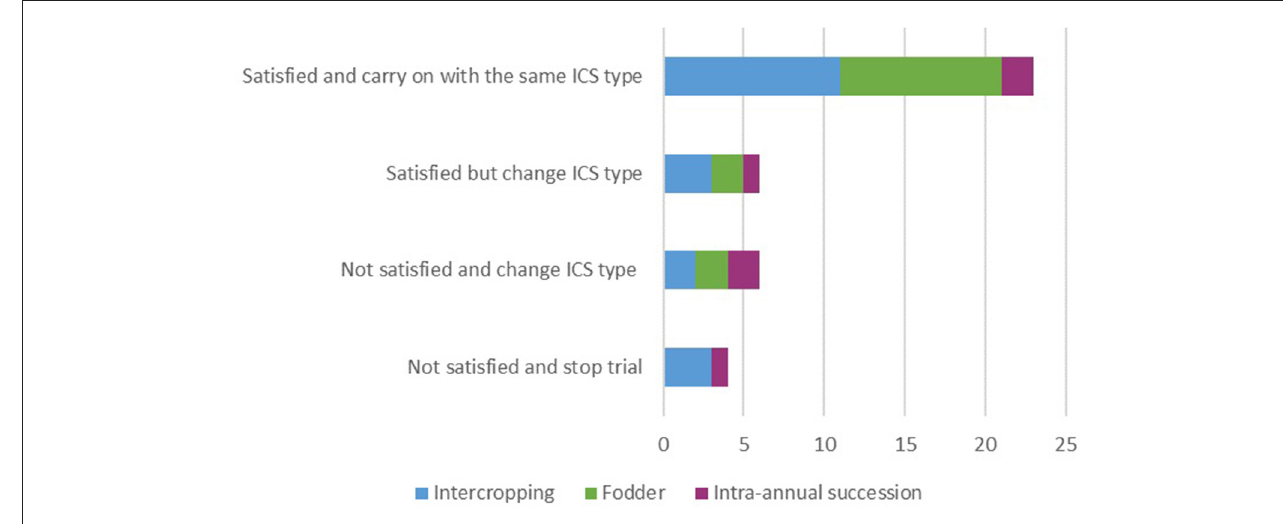
FIGURE 4 | Distribution of the type of ICS tested in 2018 based on the evaluation of the ICS made by each